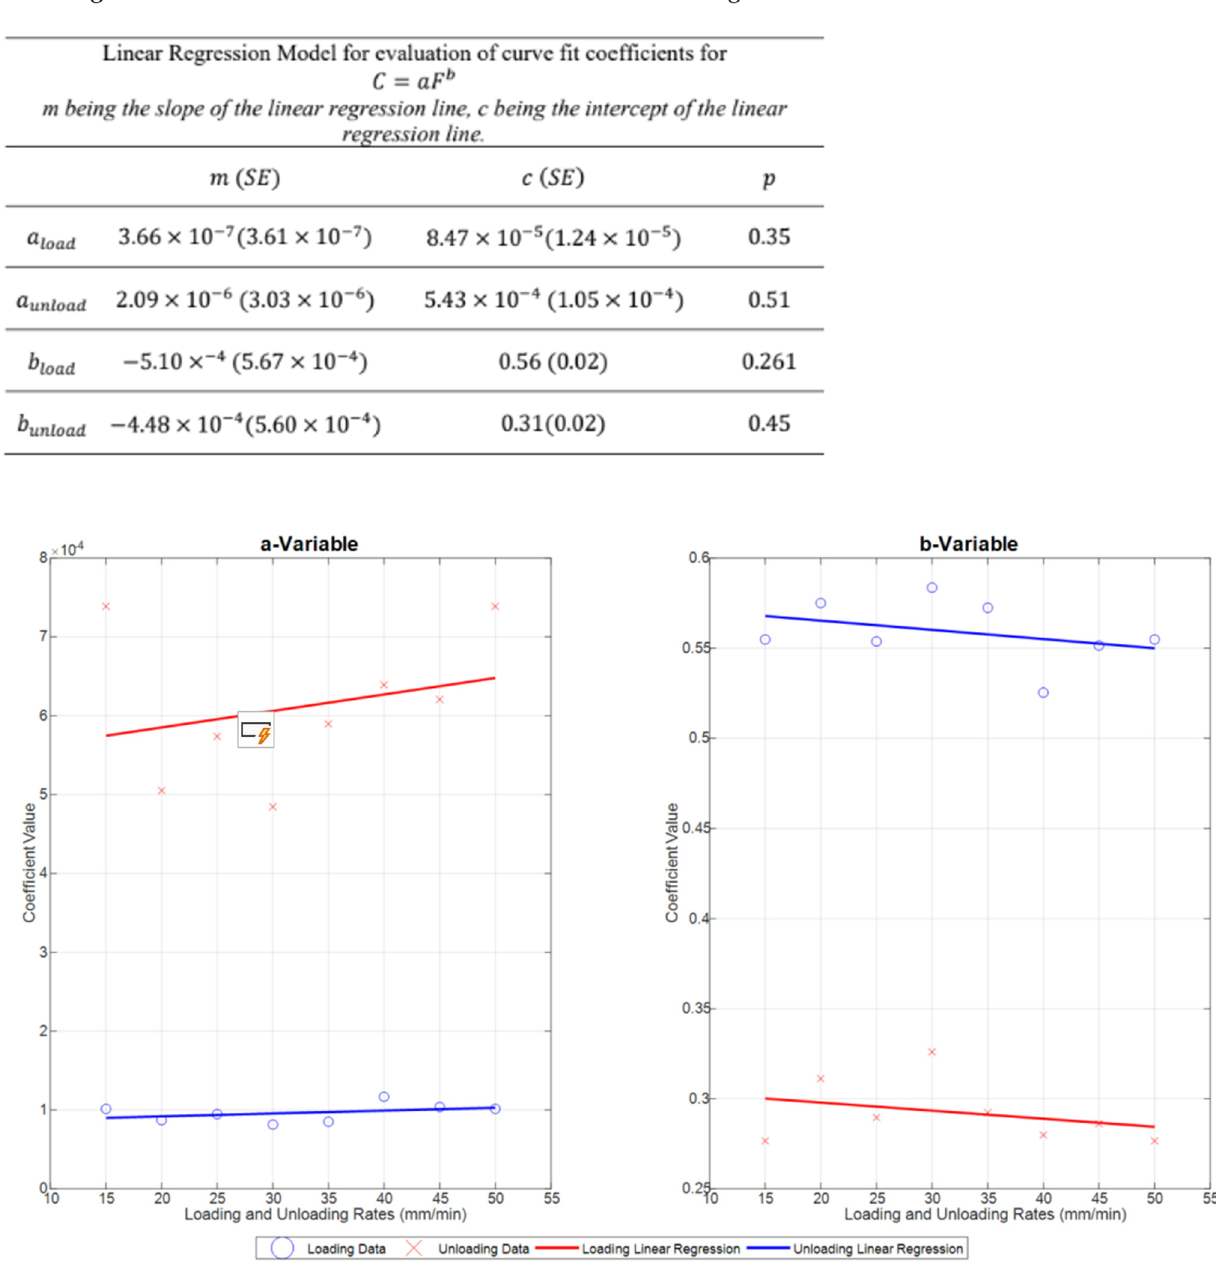
Figure 24. Plot of mean Values from Figure 21 with a fitted linear regression model.